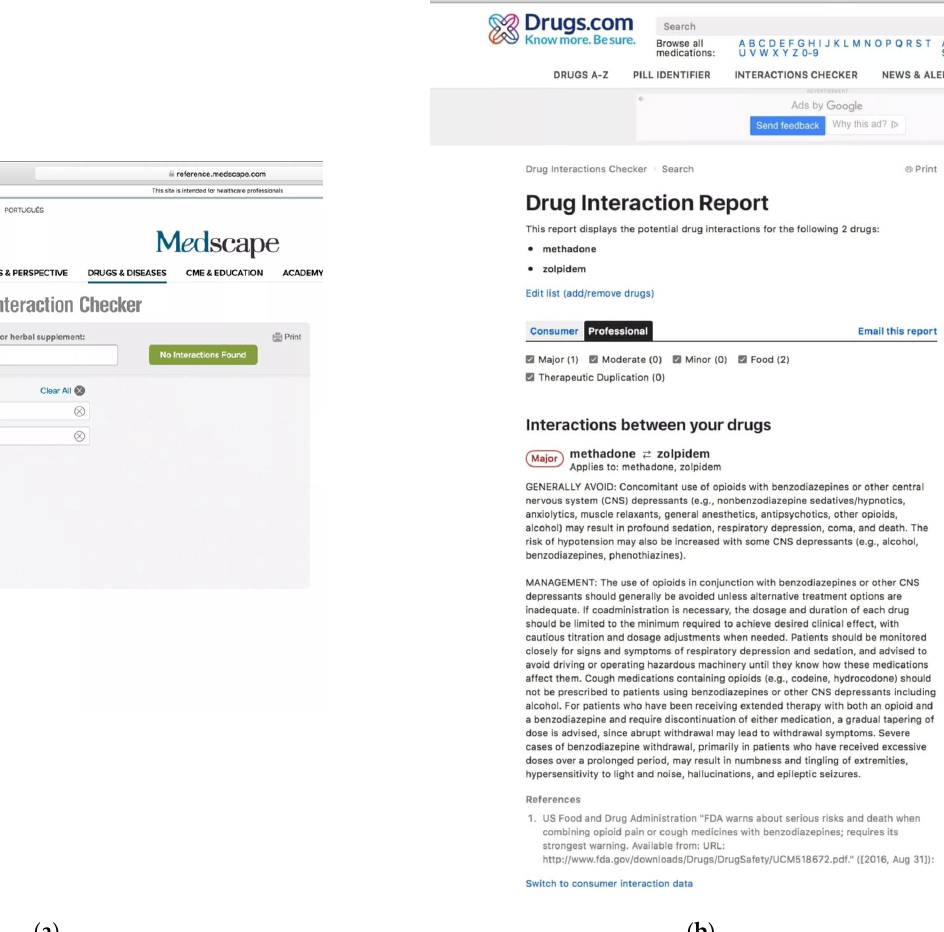
Figure 3. ( a ). Methadone–zolpidem interactions in the Medscape Drug Interaction Checker, https://reference.medscape.com/drug-interactionchecker. ( b ). Methadone–zolpidem interactions in the Drug Interactions Checker, https://www.drugs.com/drug_interactions.html.